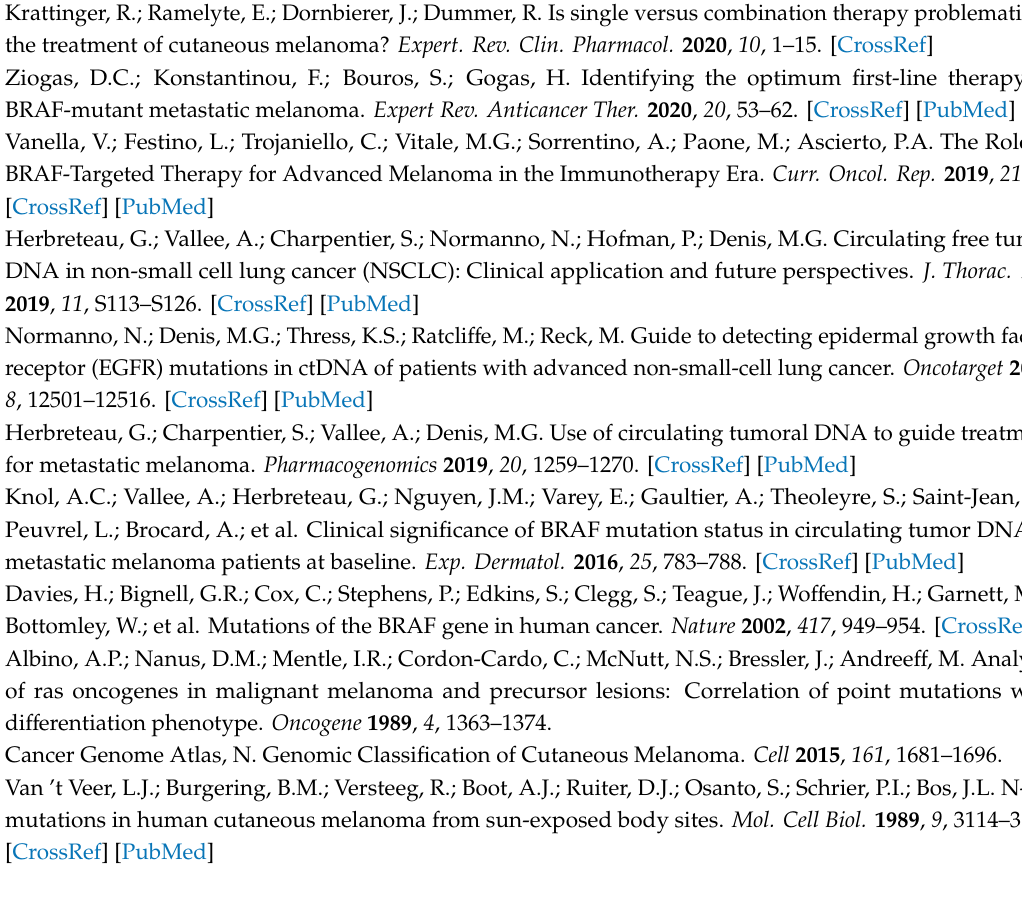
Figure S1: Kaplan–Meier estimates of Progression-Free Survival of patients treated in first line with targeted therapy ( A ) or immunotherapy ( B ); Figure S2: Kaplan–Meier estimates of Progression-Free Survival of BRAF -mutated patients ( A ) and NRAS -mutated patients ( B